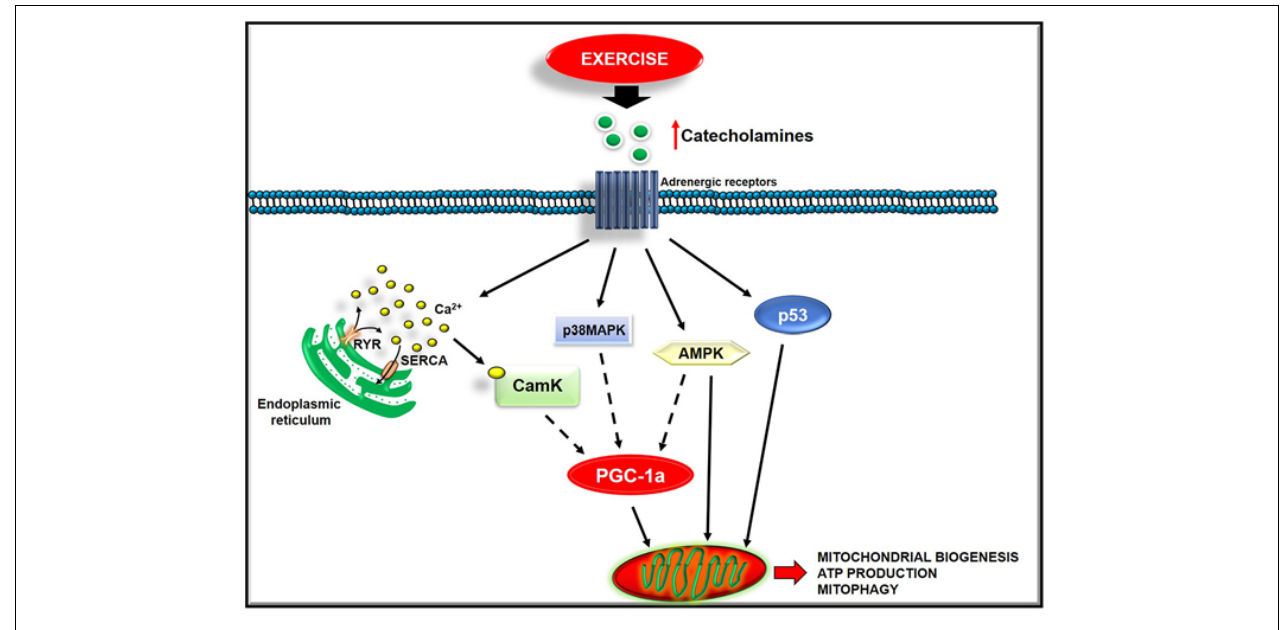
FIGURE 2 | Exercise activates several intracellular pathways to regulate mitochondrial